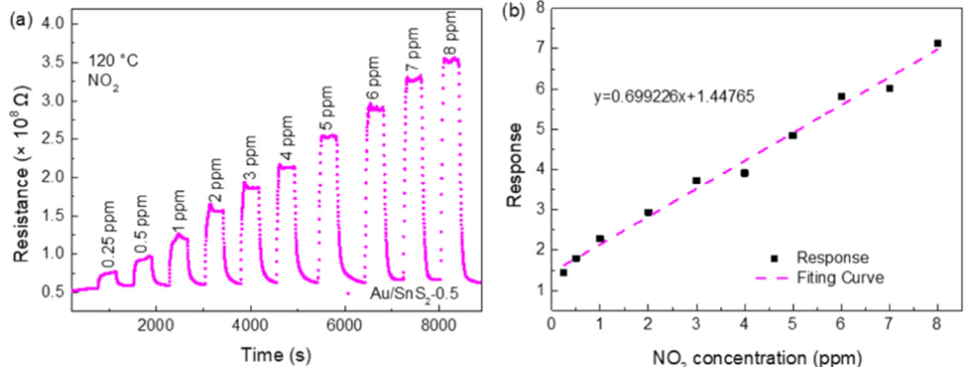
Figure 10. ( a ) The resistance curve of the Au/SnS 2 -0.5-based sensor to 0.25 ppm–8 ppm NO 2 at 120 °C. ( b ) The fitting curve of the response of the sensor with NO 2 concentrations.